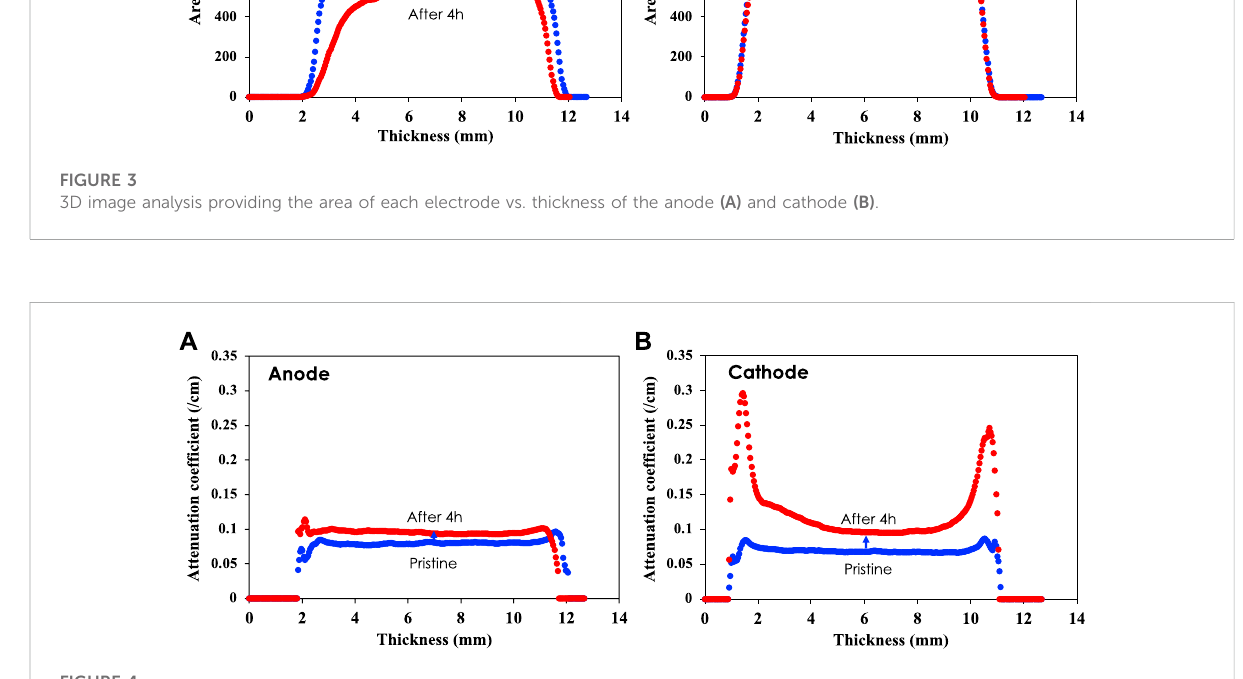
FIGURE 4 Neutron attenuation of anode (A) and cathode (B) . 3D image analysis shows that the neutron attenuation coef fi cient increases more for the cathode than for the